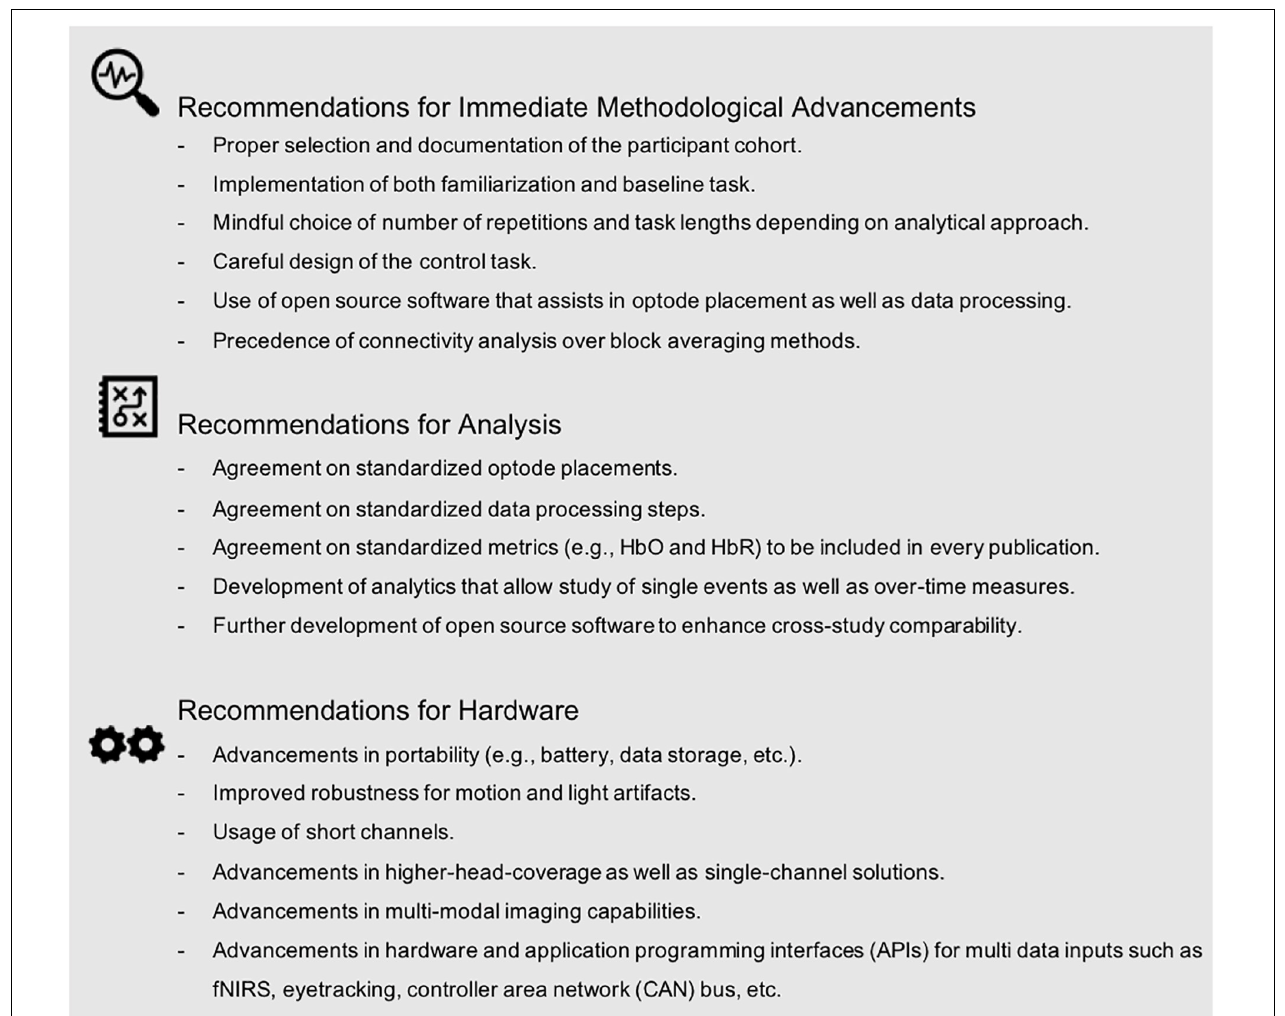
FIGURE 7 | Recommendations to advance fNIRS research for autonomous driving scenarios as identified by our methodological